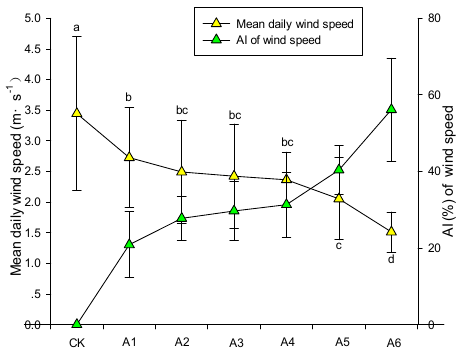
Figure 6. Variations in mean daily wind speed at 2-m height and the AI of wind speed. Means with different letters indicate significant differences at p < 0.05. Vertical bars represent ± standard deviation.